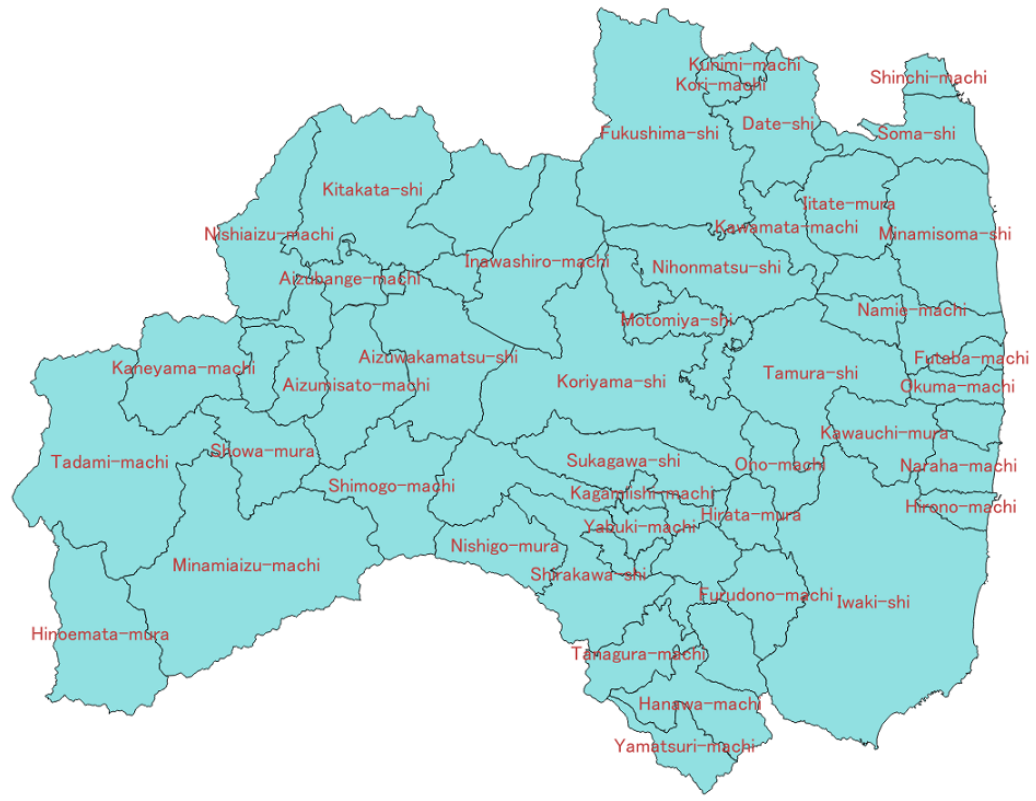
Figure 3. Municipalities of Fukushima prefecture.